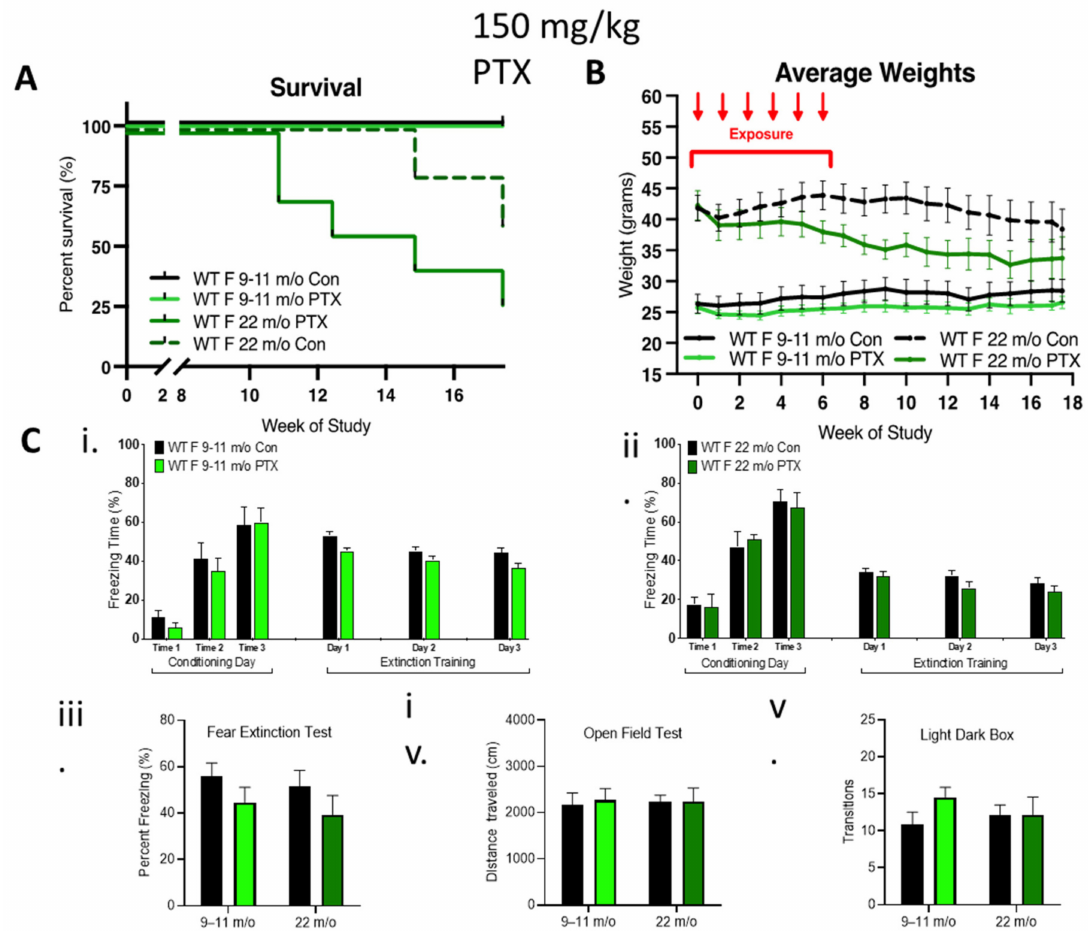
Figure 4. Effect of age on female tolerance to paclitaxel and protection from neurotoxicity induced by paclitaxel. ( A ) WT aged females were treated only with 150 mg/kg paclitaxel. The 9–11-month-old female mice ( n = 7) were tolerant to paclitaxel, whereas 75% of older mice (22-month-old, n = 7) died over 18 weeks. Significant change in survival curve log-rank (Mantel–Cox) test ( p = 0.021) was found. ( B ) The 9–11-month-old females showed stable weight as compared to controls, whereas very old females showed an age-related drop in weight that was enhanced in the paclitaxel group. Three-way ANOVA demonstrated a significant variation in age ( p < 0.0001), treatment ( p < 0.0001), and age x treatment ( p = 0.0002). ( C ) Paclitaxel administration in old (9–11-month-old) WT female mice did not impair ( i ) the acquisition of conditioned fear (three tone-shock pairings). All mice showed a graduate decrease in freezing behavior over extinction sessions (tone only) ( n = 7). ( ii ) Paclitaxel administration in very old WT female mice did not impair the acquisition of conditioned fear (three tone-shock pairings). All mice showed a graduate decrease in freezing behavior over extinction sessions (tone only) (control n = 5, treated n = 4). ( iii–v ) No significant difference (two-way ANOVA) in fear extinction (9–11-month-old control and treated n = 7, older control n = 5, treated n = 4), mobility (very old control n = 5, treated n = 6), or anxiety behavior (very old n = 5) in old or very old females after 150 mg/kg paclitaxel treatment. Graphs designate mean ±